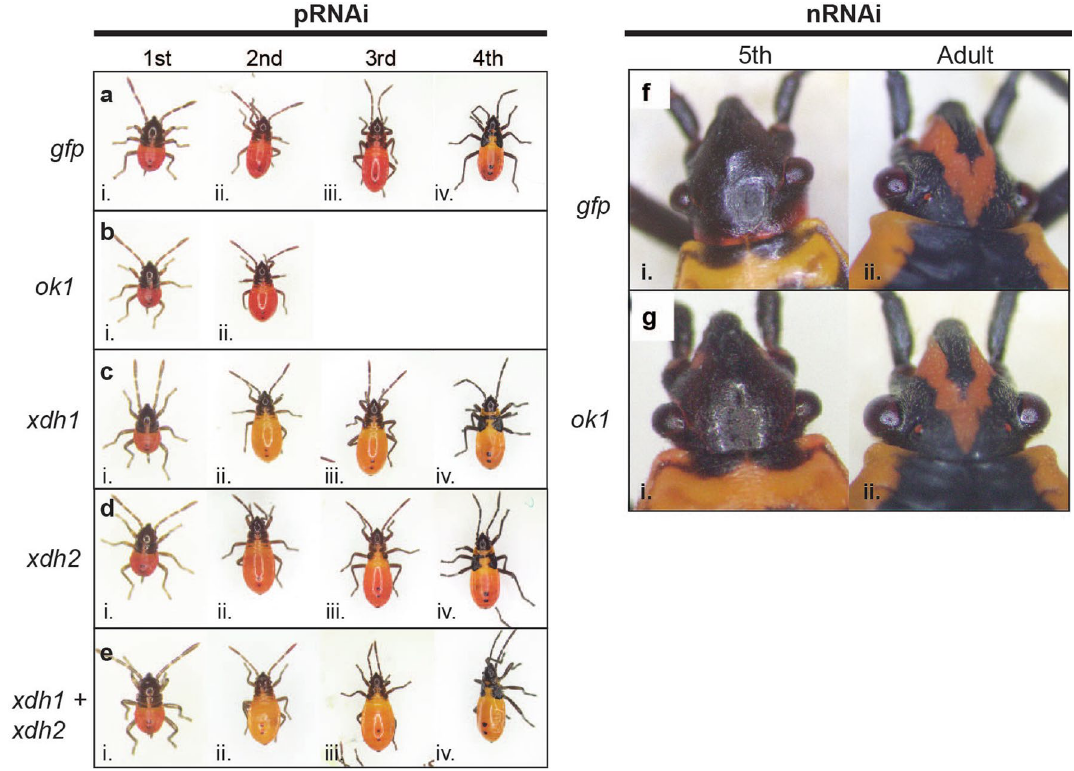
Figure 1. RNAi targeting pteridine synthesis pathway in Oncopeltus . Photos of nymphs and adults, as indicated. (A) Offspring of females injected with a gfp dsRNA control exhibit wild type phenotypes at (i) first, (ii) second, (iii) third, and (iv) fourth instars. ( B ) Offspring of females injected with Of-ok1 dsRNA were indistinguishable from controls. pRNAi knockdown of ( C ) Of-xdh1 , ( D ) Of-xdh2 , or ( E ) Of-xdh1 and Of-xdh2 . Knockdown of Of-xdh1 caused a lightening of body color from red (A) to yellow-orange, particular evident in second through fourth instars ( Cii–iv; Eii–iv ). ( F,G ) Nymphal RNAi. The eye color of last instar nymphs and adults are similar in controls ( Fi,ii ) and after nRNAi ok1 ( Gi,ii